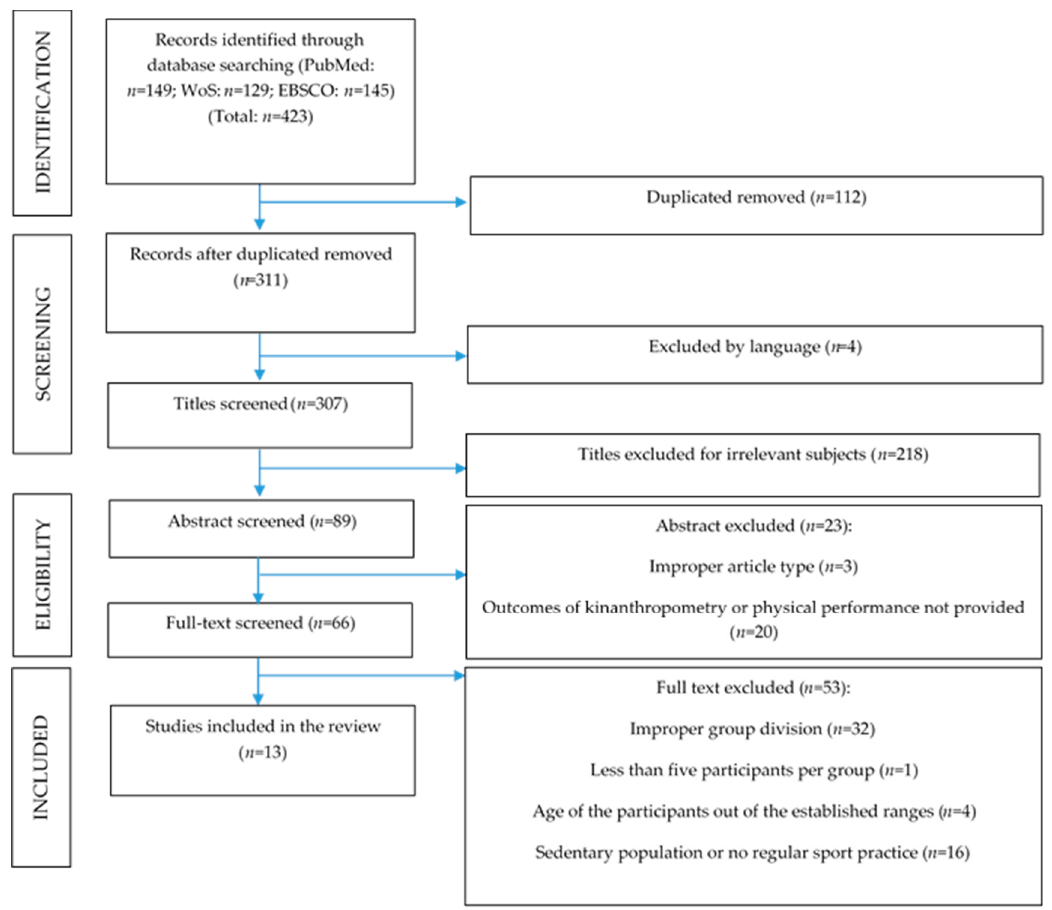
Figure 1. Flow diagram for the search and screened and included articles.